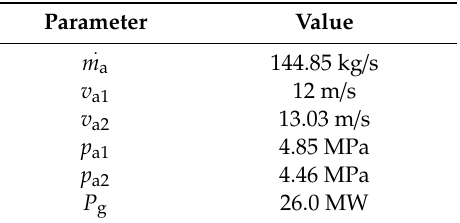
Table 3. Results for a CAES system with water hammer